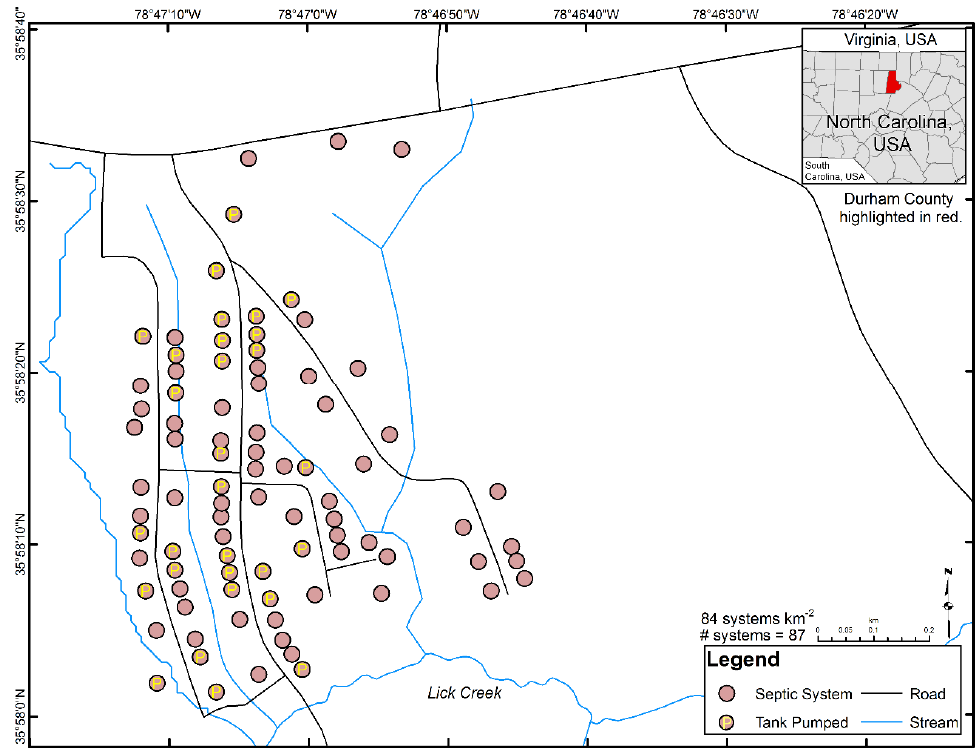
Figure 1. Map showing the relative locations of septic systems within the studied high-density watershed located within Durham County, North Carolina. Approximately 33% of the subdivision agreed to volunteer, and their tanks were pumped.